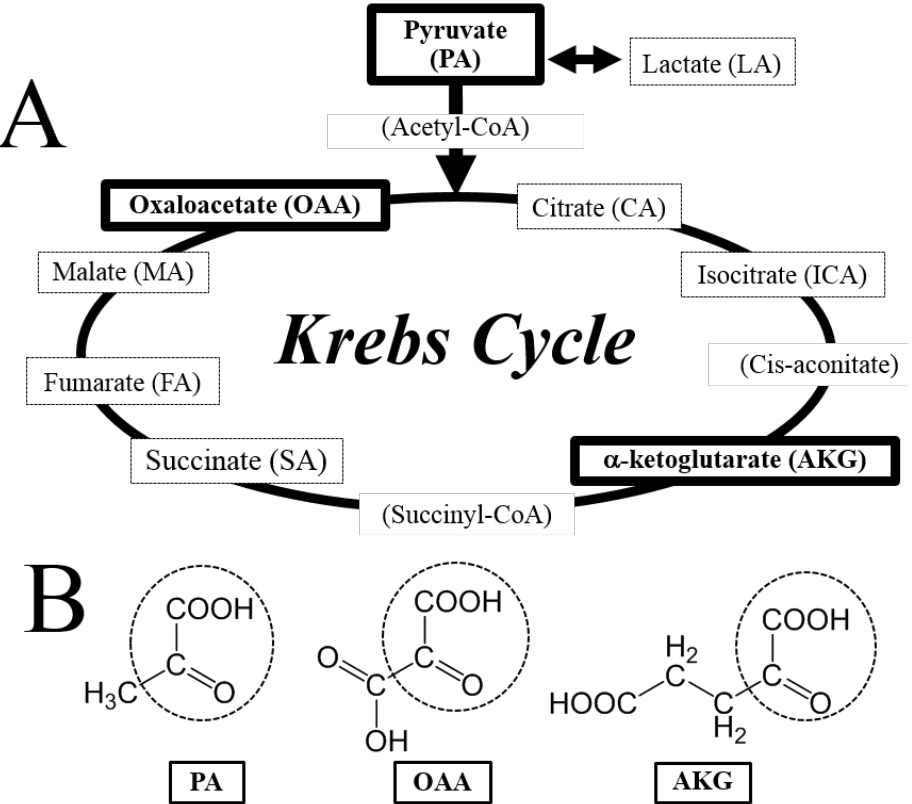
Figure 6. ( A ) Compounds involved in the Krebs cycle and ( B) common chemical structure of neuroprotective KCIs (PA, OAA, and AKG). Note that PA, OAA, and AKG have the common chemical structure of the α -keto acid group—indicated by the dotted circle—with which molecules can directly react with H 2 O 2